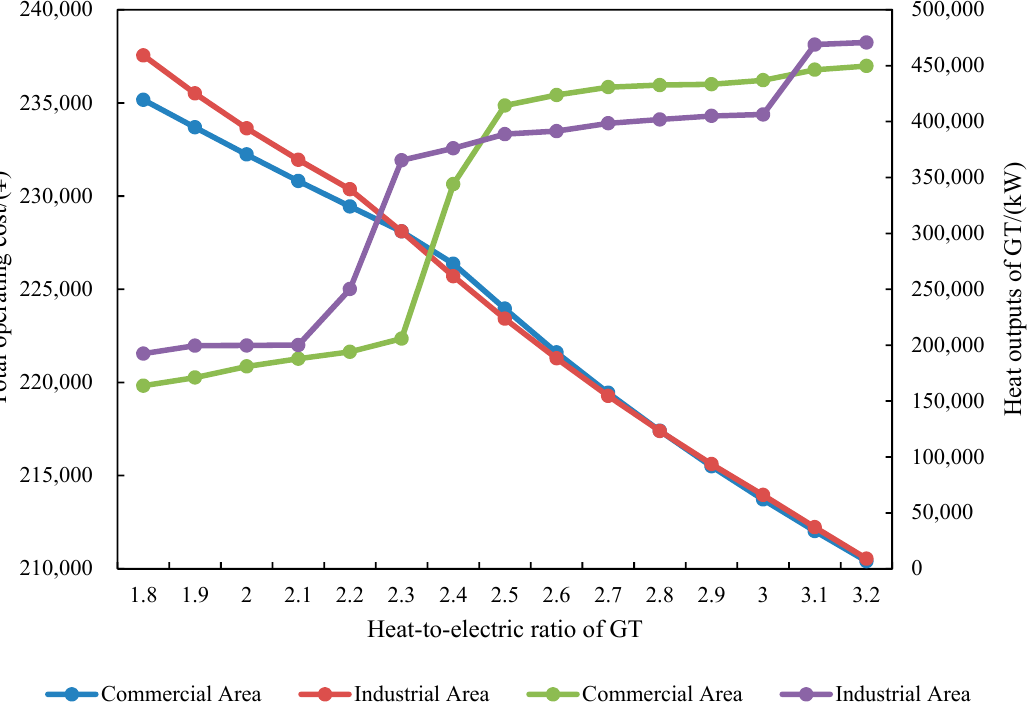
Figure 14. Sensitivity analysis of the total operating cost and the heat-to-electric ratio of GT.